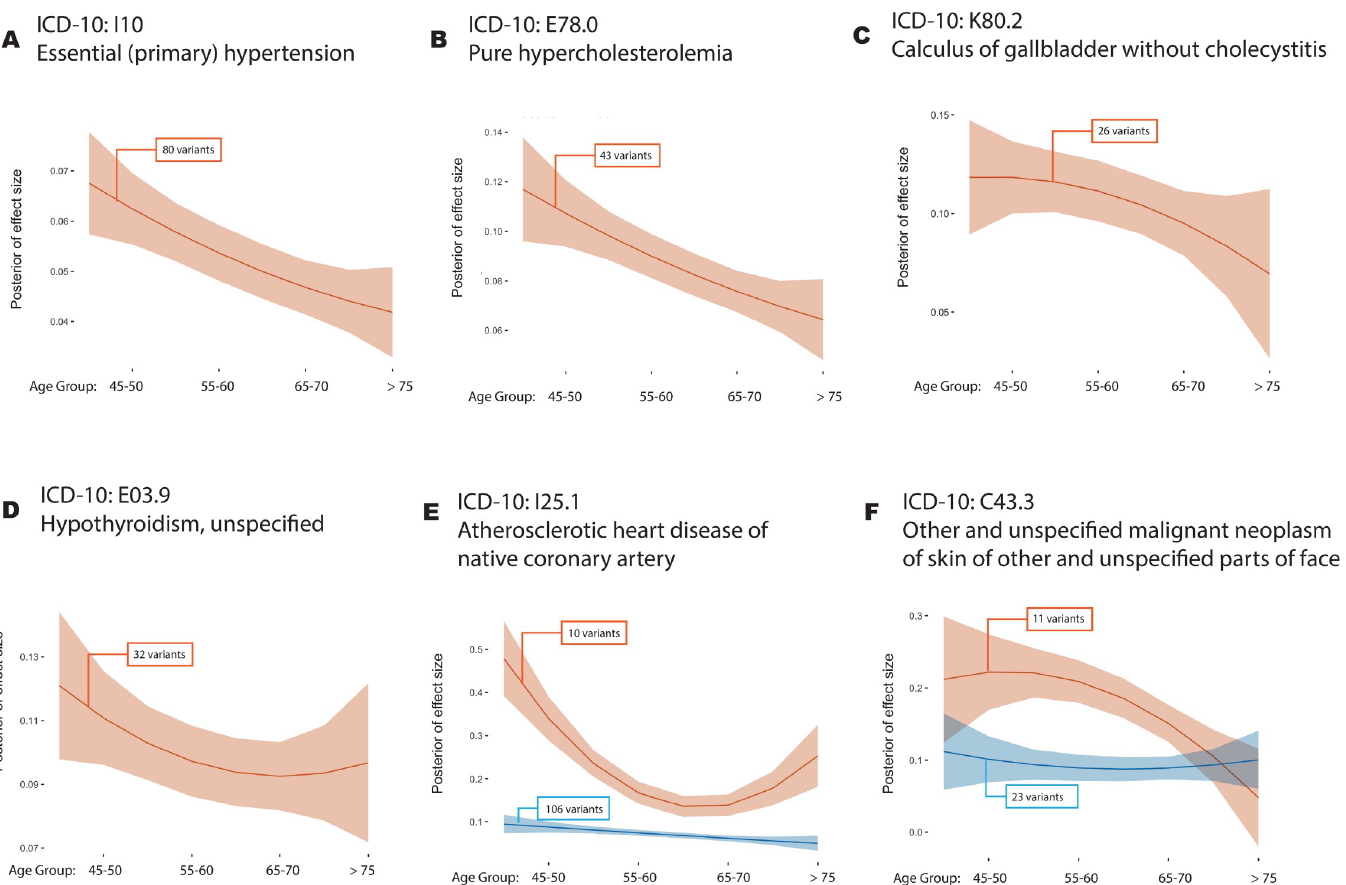
Fig 4. Age-varying disease risk profiles. ( A-D) Inferred cluster profiles for four disorders where there is evidence for single non-constant profile; “Primary (essential) hypertension” (ICD-10 code I10; P = 0.0001), “pure hypercholesterolaemia” (E78.0; P = 0.0001), “Calculus of gallbladder without cholecystitis” (K80.2; P = 0.0236) and “Hypothyroidism, unspecified” (E03.9, P = 0.0329); (E-F) Inferred cluster profiles for two disorders where there is evidence for multiple non-constant profiles; “atherosclerotic heart disease of native coronary artery” (I25.1; P = 0.0001) and “other and unspecified malignant neoplasm of skin and unspecified parts of face” (C44.3; P = 0.0092). Curves for all diseases are shown in S4 Fig; Curves for all UK Biobank subjects regardless of ethnic background and for subjects from Black or South Asian ethnic background are shown in S6 Fig. The solid line indicates the posterior mean and the shaded area the 95% credible interval; Numbers in boxes indicate the number of variants in each cluster; All estimates are made with quadratic models for age-varying risk